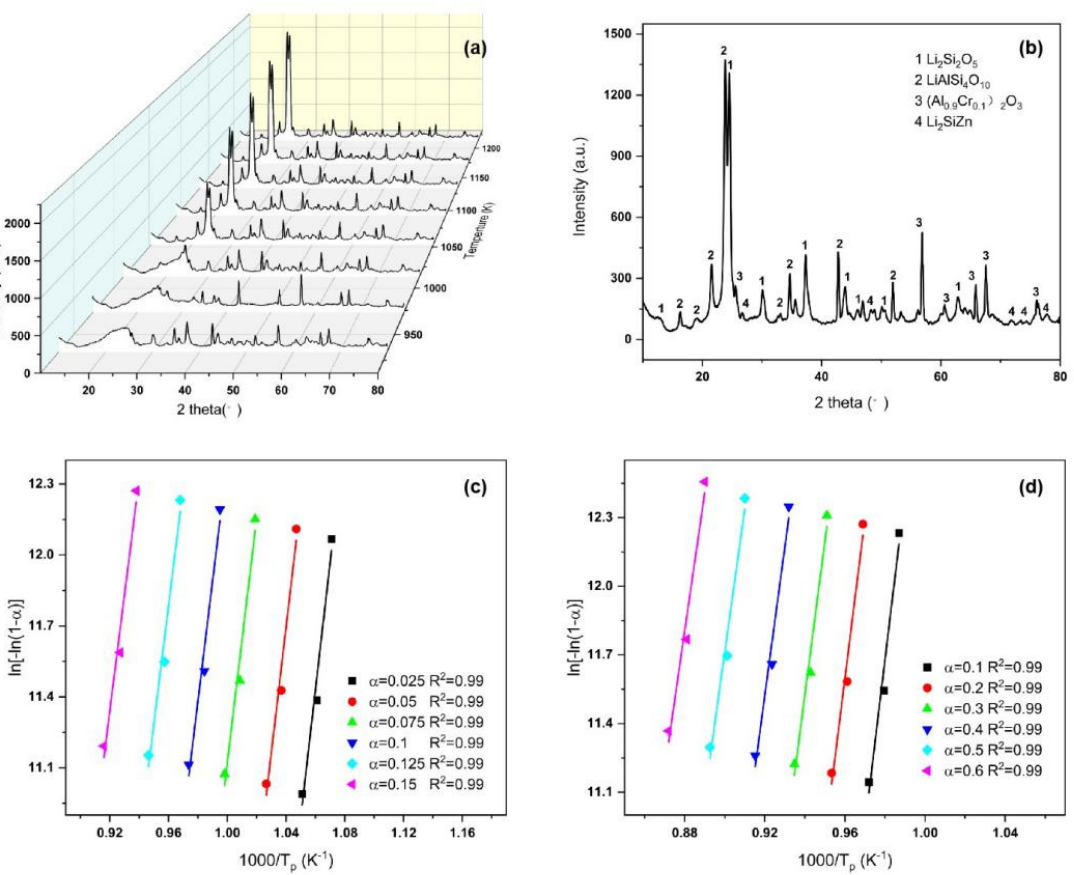
Figure 5. ( a ) HT-XRD patterns of Li 2 O–Al 2 O 3 –SiO 2 glass samples from 833 K to 1213 K; ( b ) XRD patterns of L i2 O–Al 2 O 3 –SiO 2 glass samples at 1133 K; ( c , d ) plots of ln( T α 2/ β ) vs. 1000/ T α for different integration numbers of Li 2 Si 2 O 5 and LiAlSi 4 O 10.